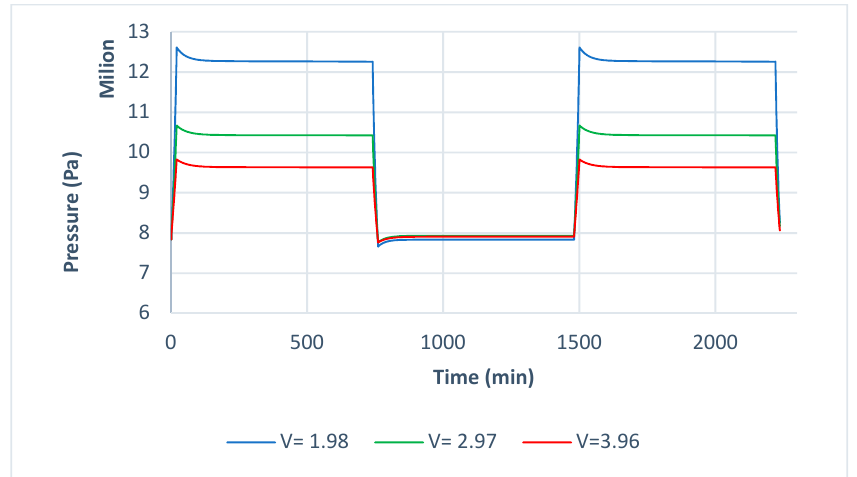
Figure 10. Pressure gas trend for the First Configuration varying the Volume of the tank.